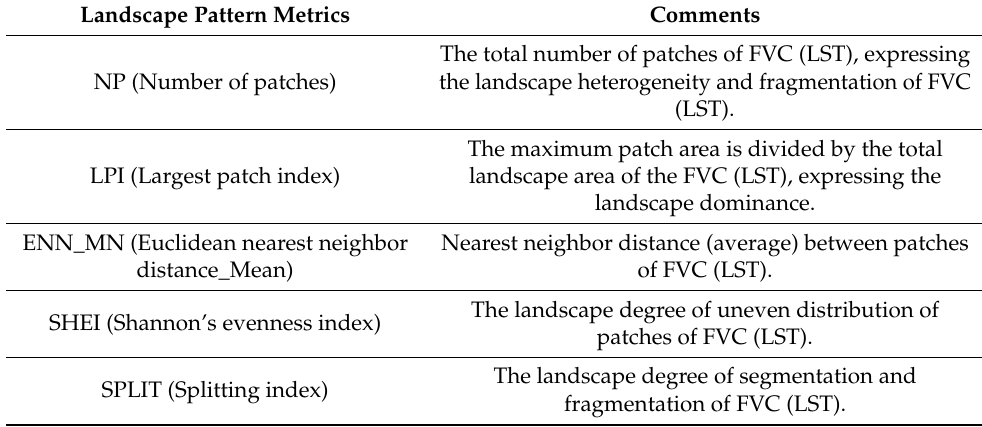
Table 3. Landscape pattern metrics